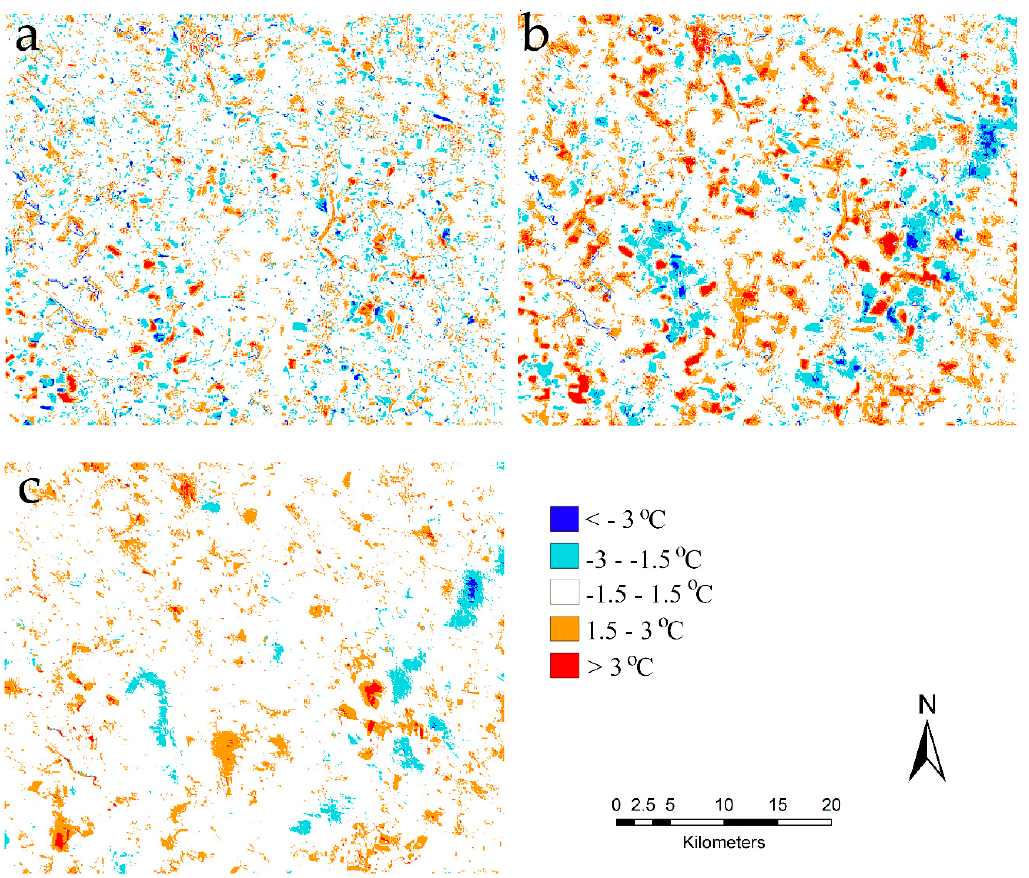
Figure 8. Residuals maps of ( a ) TsHARP Landsat at a 60-m spatial resolution. ( b ) TsHARP Sentinel at a 60-m spatial resolution, and ( c ) di ff erence between TsHARP Landsat and TsHARP Sentinel for Site